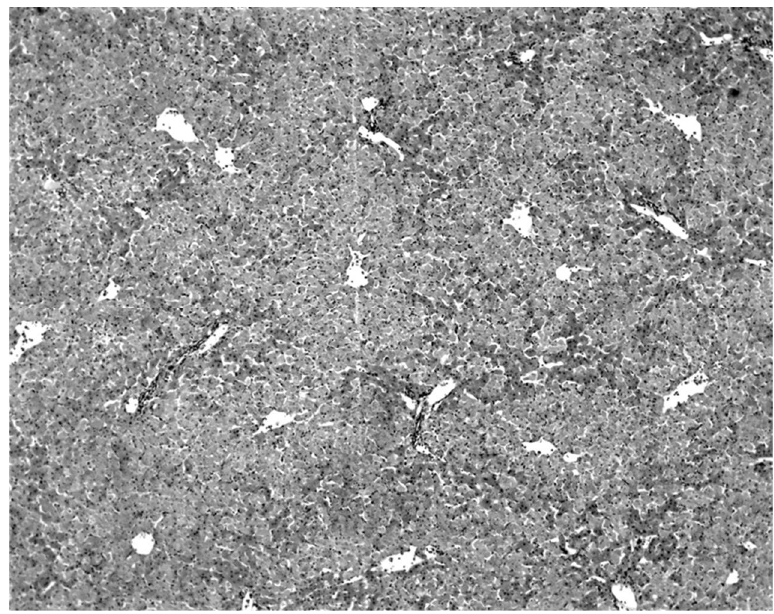
Figure 2. Massive liver cell destruction in a moribund wrinkle-lipped free-tailed bat naturally infected with KKV.